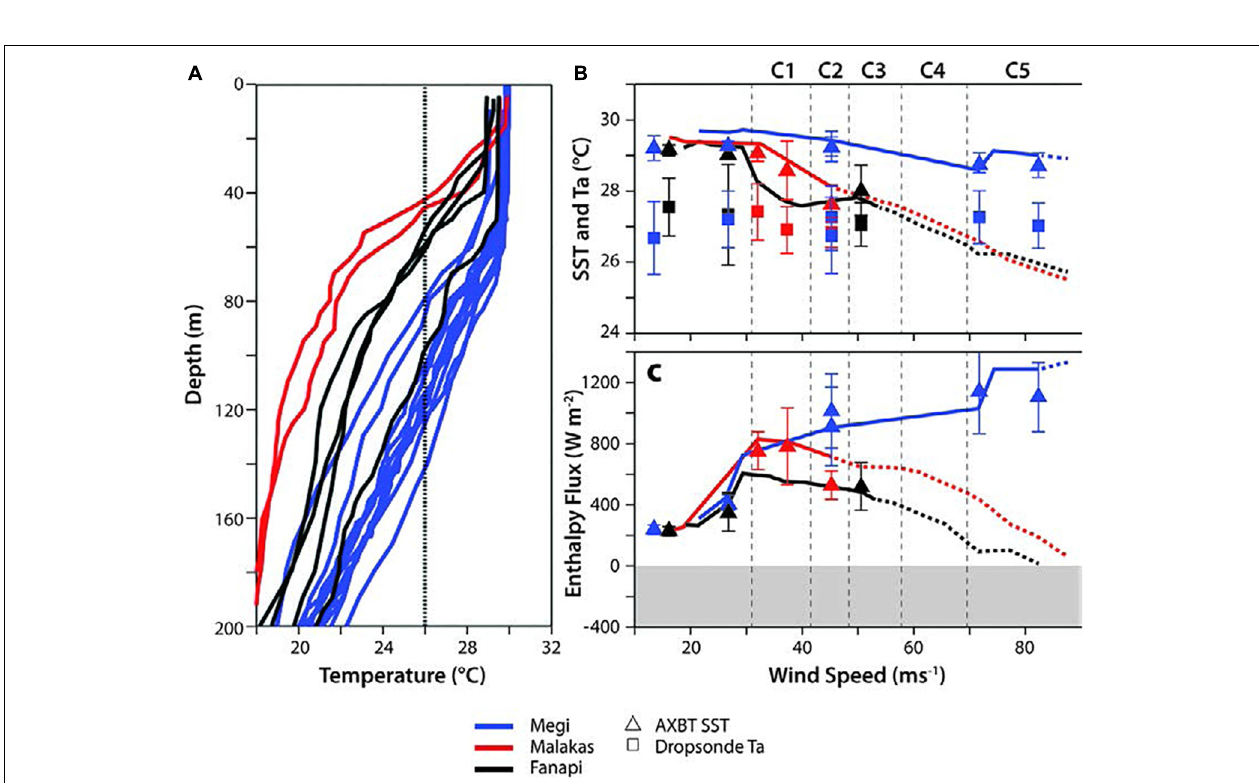
FIGURE 11 | Evolution of temperature and air–sea fluxes for three ITOP TCs (Megi, Fanapi, and Malakas). (A) Pre-TC temperature profiles from ARGO floats. (B) Symbols: SST and air temperature at the core of each TC as measured by dropsonde/AXBT pairs. Lines: results of an ocean model (Price et al., 1994) driven by the observed TC (solid) and extrapolated to higher wind speeds (dashed). (C) As in (B) , but for estimated total enthalpy flux (after Lin et al.,